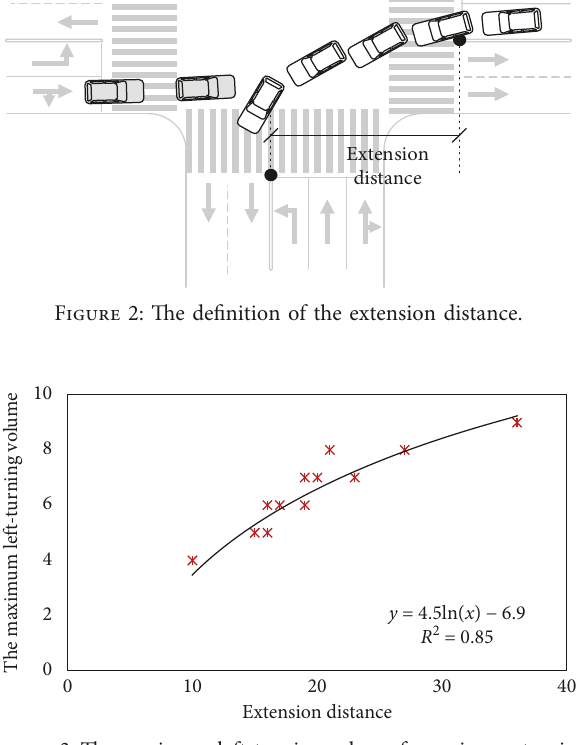
Figure 3: The maximum left-turning volume for various extension